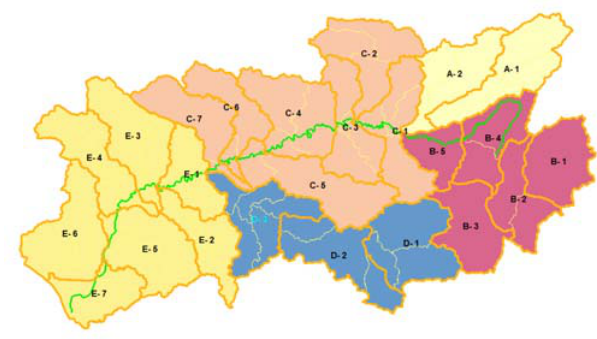
Figure 3. Planned zoning for the Guadalquivir river basin district: 5 zones and 24 sub-zones.